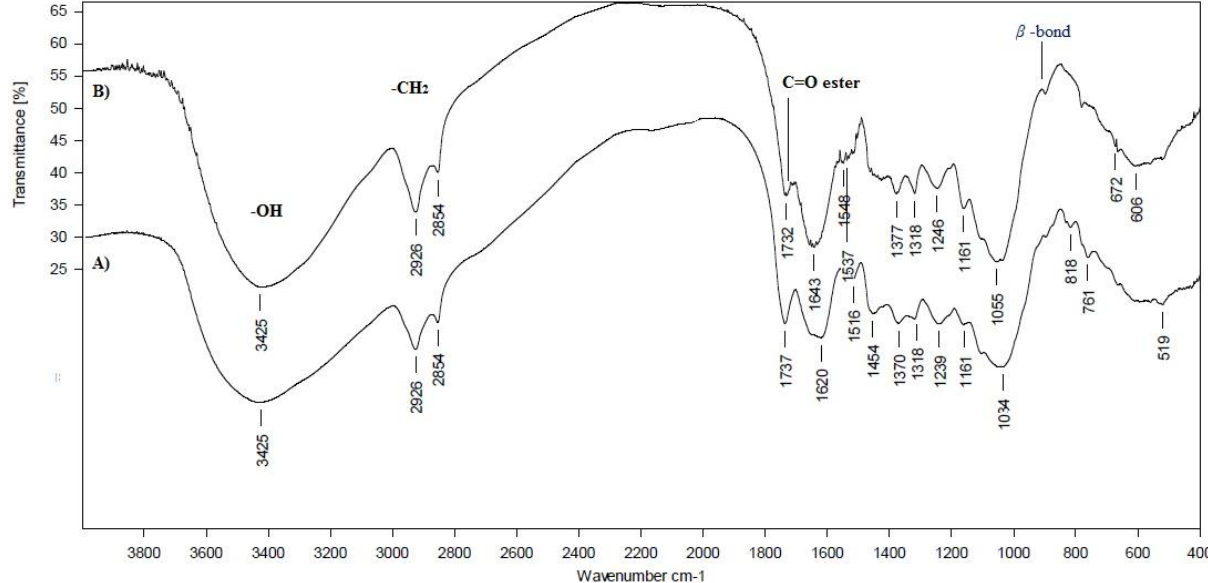
Figure 6. FTIR spectra of steam distilled lavender straw (SDLS) substrate (A) and mycelium SDLS - based bio - composite (B).